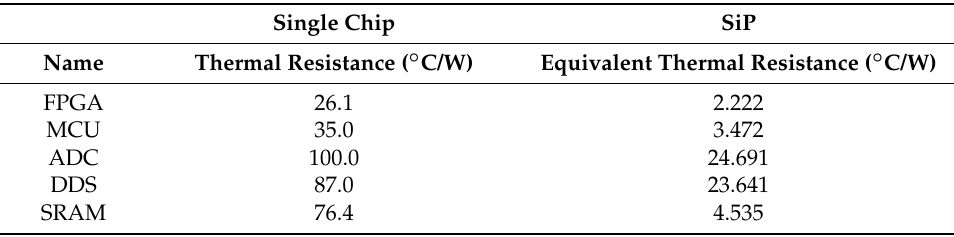
Table 2. Thermal resistances between the single chips and the